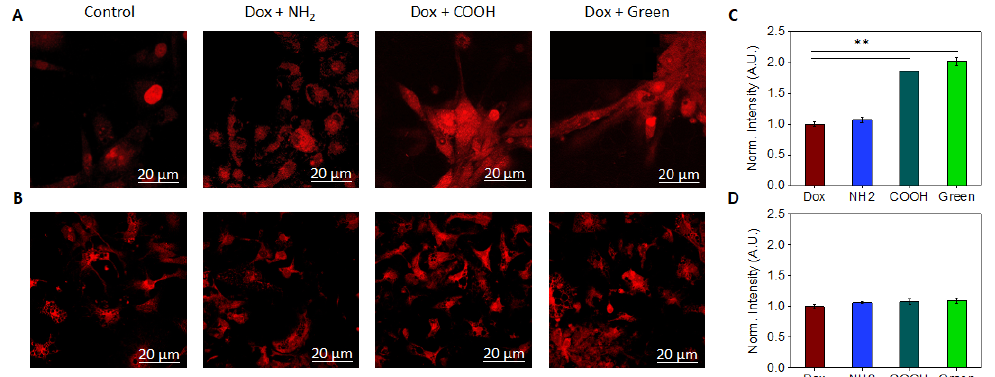
Figure 5. Dox uptake inside U87 ( A ) and cortical primary neurons ( B ) after the pretreatment with GQDs at 250 µg/mL. Fluorescence intensity of Dox inside U87 cells ( C ) and inside cortical neurons ( D ). ** p < 0.01, one-way ANOVA and Tukey post hoc test.